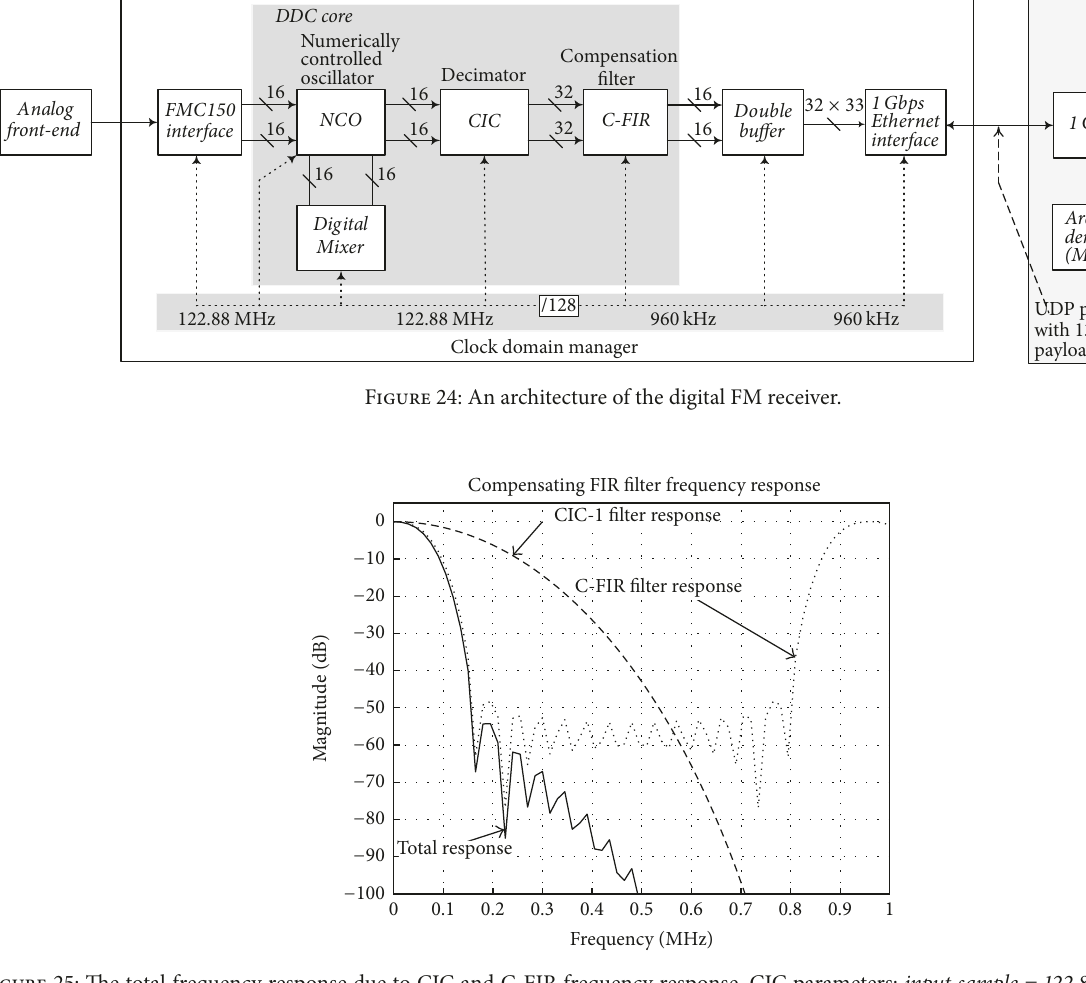
Figure 25: The total frequency response due to CIC and C-FIR frequency response. CIC parameters: input sample = 122.88 MSPS, output sample rate = 960 kSPS, decimation factor (R) = 128, number of stages (N) = 10, differential delay (M) = 1. C-FIR parameters: input and output sample rate = 960 kSPS, number of coefficients = 21, cutoff frequency = 90 kHz, stopband attenuation =